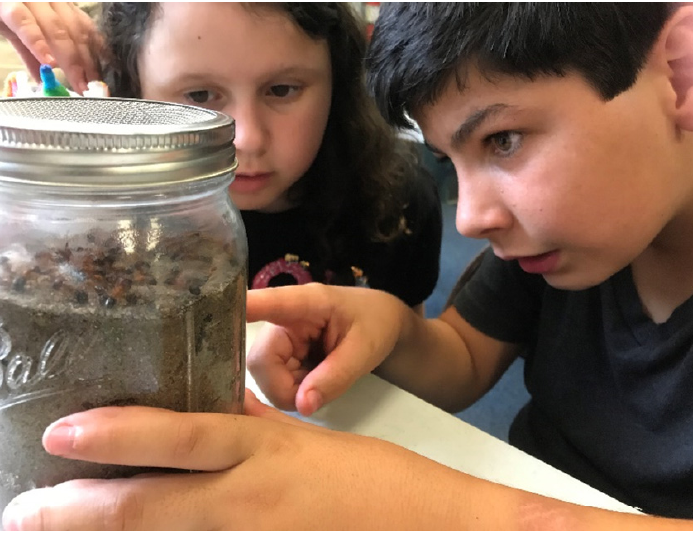
Figure 3. Fifth graders looking at Florida carpenter ants. Picture by M.S. Ascunce.